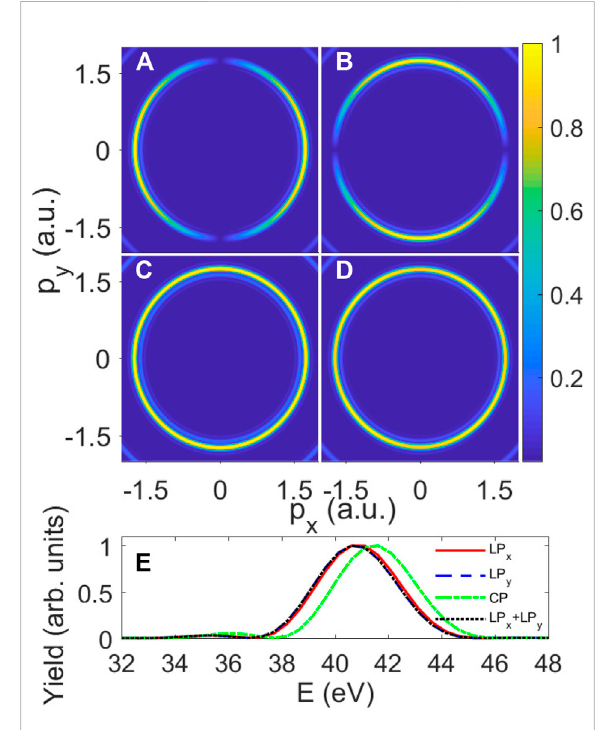
FIGURE 6 Normalized photoelectron momentum distribution of hydrogen atoms in the presence of a circularly polarized laser pulse with different polarization. (A) Linearly alone x , (B) Linearly alone y , (C) Circularlyand (D) superpositionof (A,B) .Curvesin thepanel (E) are thephotoelectron spectra of (A) thered solid line, (B) the blue dashed line, (C) the green dashed – dotted line, and (D) the black dotted line. Laser intensity is I 0 =1×10 18 W/cm 2 . The rest of laser parameters are the same as those in Figures